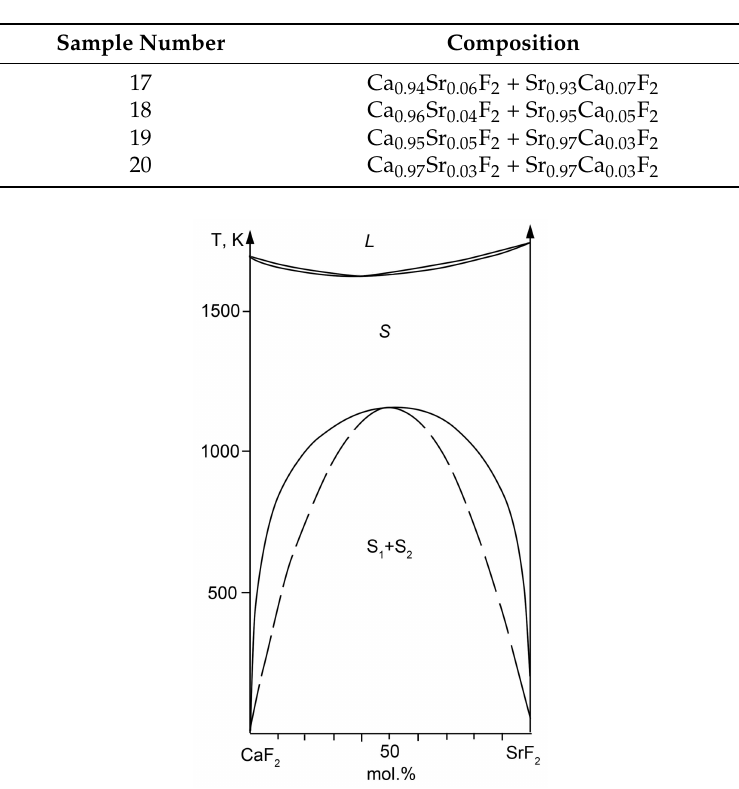
Table 3. Compositions of the specimens synthesized in the SrF 2 –CaF 2 system.